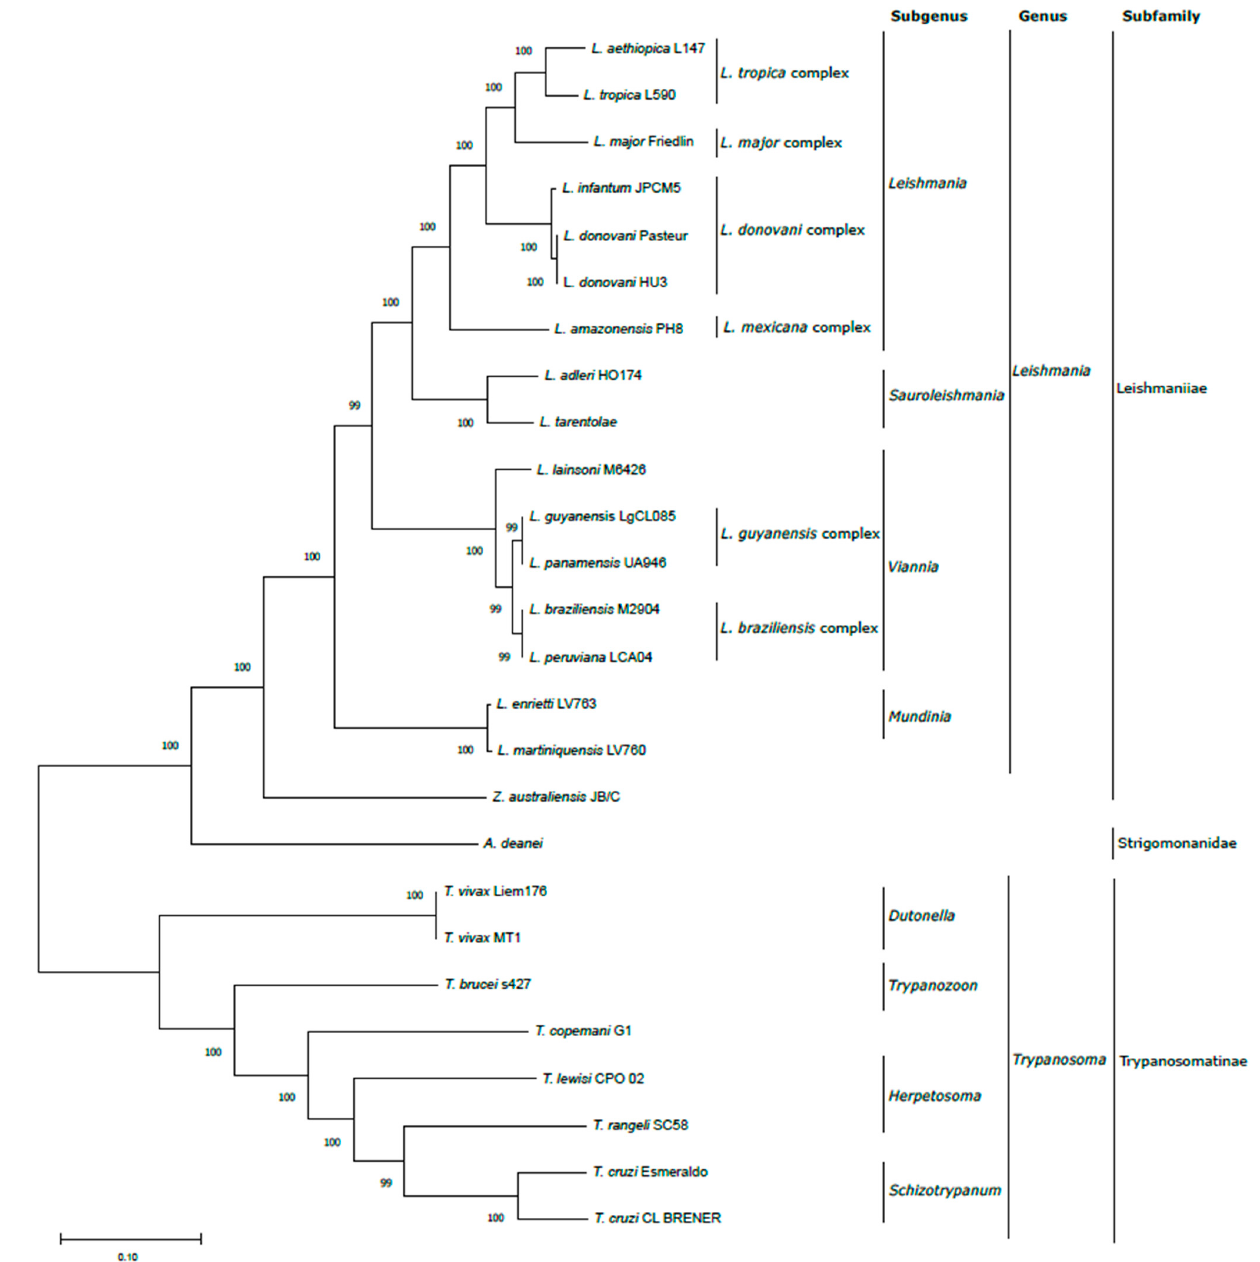
Figure 2. Evolutionary analysis of the Trypanosomatidae family based on the CR of the maxicircle sequence. The evolutionary history was inferred using the maximum likelihood method and the Tamura–Nei model (Tamura and Nei 1993). The tree with the highest log likelihood ( − 166,927.58) is shown. The percentage of trees in which the associated taxa are clustered together is shown next to the branches. The tree is drawn to scale, with branch lengths representing the number of substitutions per site. This analysis involved 26 nucleotide sequences. Codon positions included were 1st + 2nd + 3rd + Noncoding. There was a total of 16,895 positions in the final dataset. All the evolutionary analyses were conducted in MEGA 11 [45].